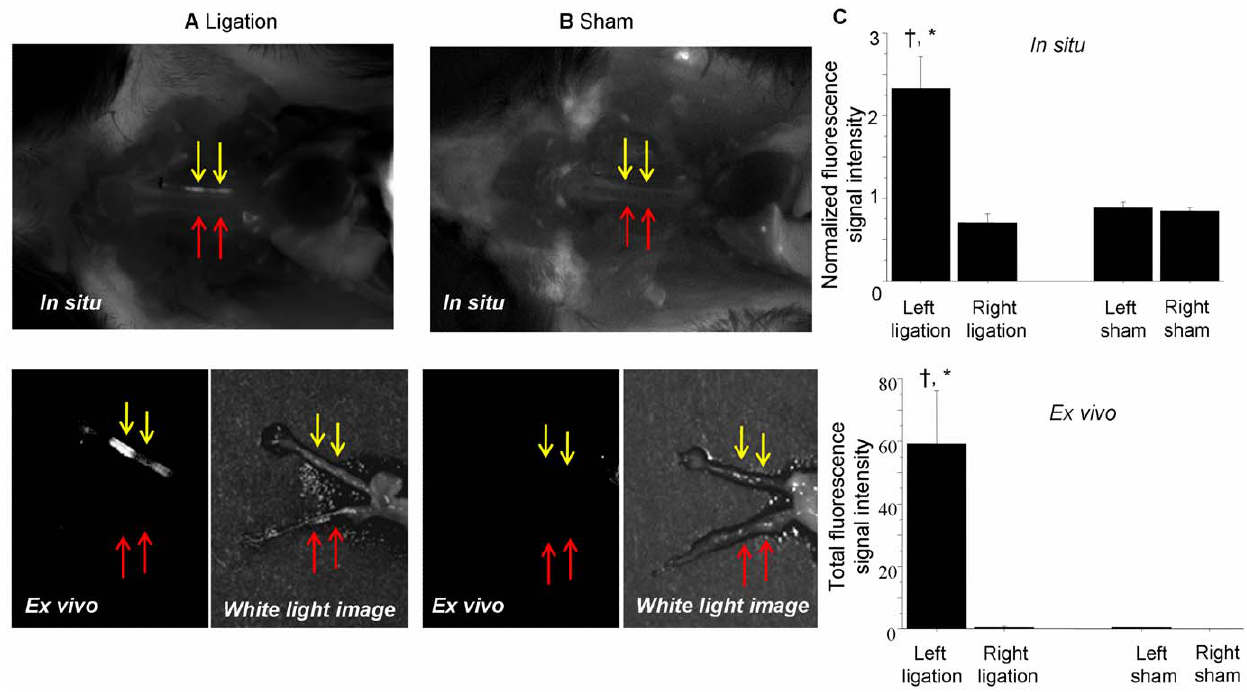
Figure 1. Fluorescence imaging of FeCo/GC in mouse carotid arteries. ( A ) Both in situ and ex vivo images at 48 hours after FeCo/GC-Cy5.5 injection showed enhanced fluorescence signal localized to the ligated left carotid artery (yellow arrows), but not to the contralateral non-ligated right carotid (red arrows). ( B ) Sham-operated mice showed no significant signal in either the left or right carotid arteries. ( C ) Quantitative analysis of both in situ and ex vivo fluorescence signal intensity showed significantly greater fluorescence from ligated left carotid arteries compared to non- ligated right carotid arteries. { p=0.03 vs. right carotid, *p=0.046 vs. sham left carotid.